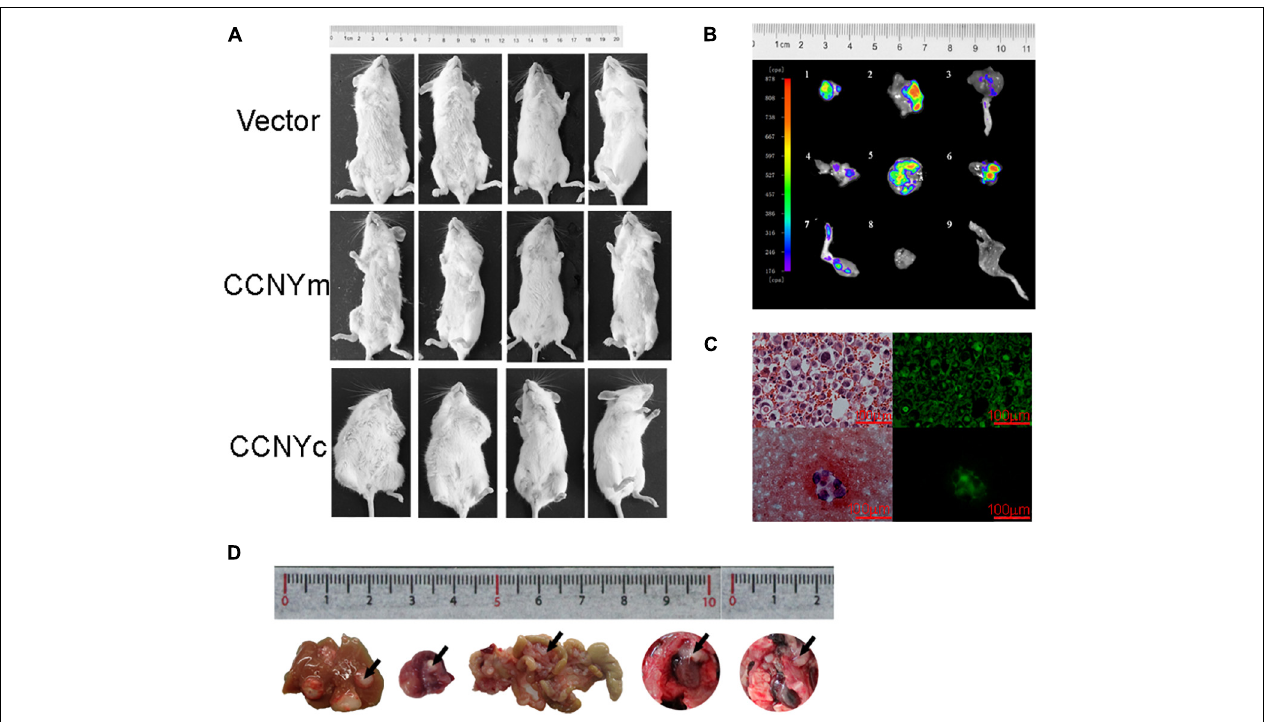
FIGURE 4 | CCNYc expression promoted the metastatic potential of H1299 cells in vivo . (A) Images of mice taken 9 weeks after tail vein injection. (B) GFP images of metastatic tumors separated from mouse tail vein injected with H1299-CCNYc cells. 1–8, metastatic tumors (1, 2, 5, 6, abdominal lymph node; 3, 7, legs; 4, mesenteric lymph node metastasis); 8, 9, muscle tissue and leg from a mouse, used as a control. (C) Ascites appeared in one of eight mice injected subcutaneously with H1299-CCNYc cells. The upper panel shows a paraffin section of the ascites: tumor cells existed in the ascites, and green fluorescence was detected (right panel). The lower panel shows a smear of the ascites: tumor cells were also detected in the ascites, and green fluorescence was detected (right panel). (D) Images of metastatic organs (liver, celiac lymph nodes, mesentery, and pleura) separated from mice injected subcutaneously with H1299-CCNYc cells. The arrows pointed out the metastatic tumors in the